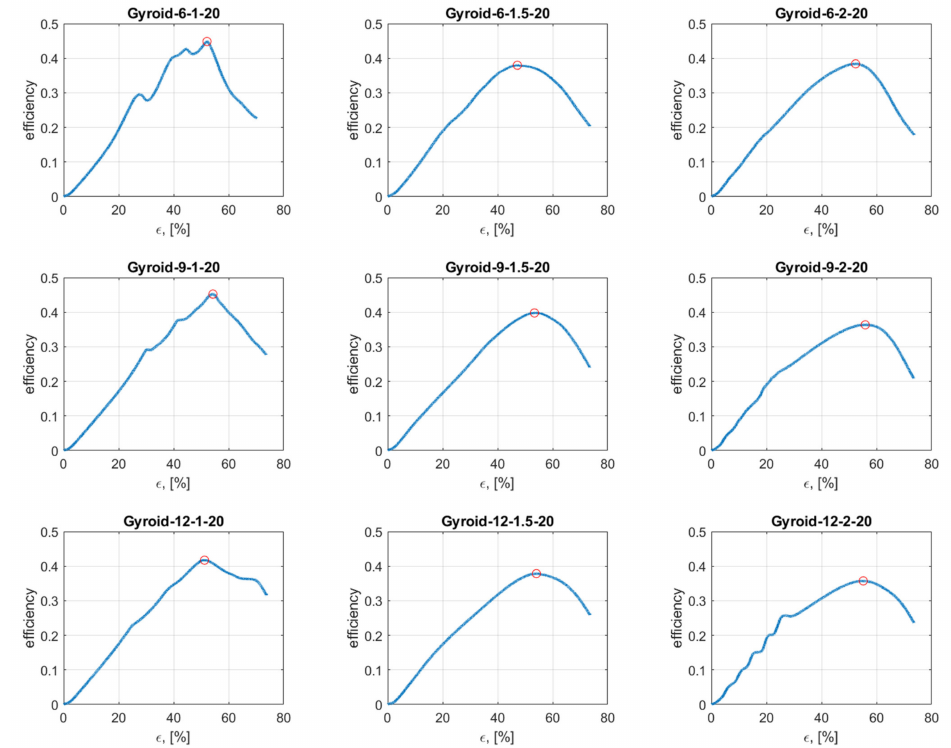
Figure 13. Efficiency–strain curve of tested cylindrical mapped gyroid